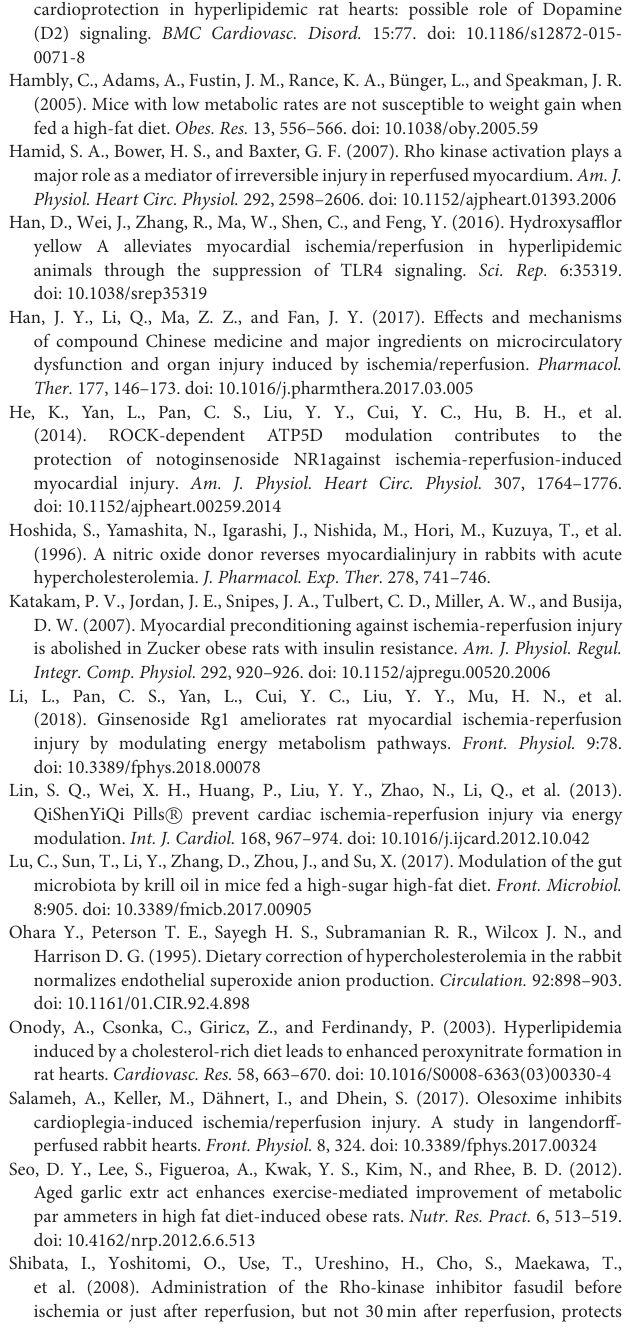
Figure S2 | The full-length representative western blotting bands of ROCK, RhoA and GAPDH in different groups as shown with indication of molecular size. The samples derived from the same experiment and gels were processed in parallel. Selected fractions of bands used in the main text were framed as shown in the